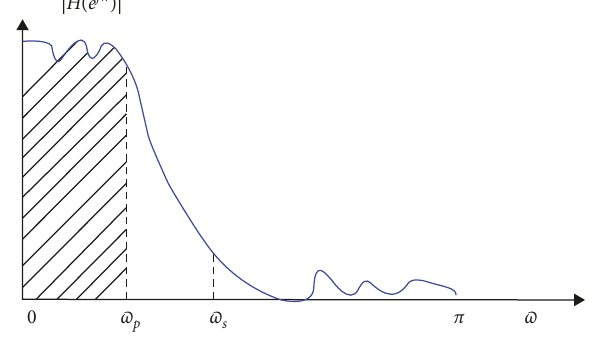
Figure 5: Actual characteristics of low-pass